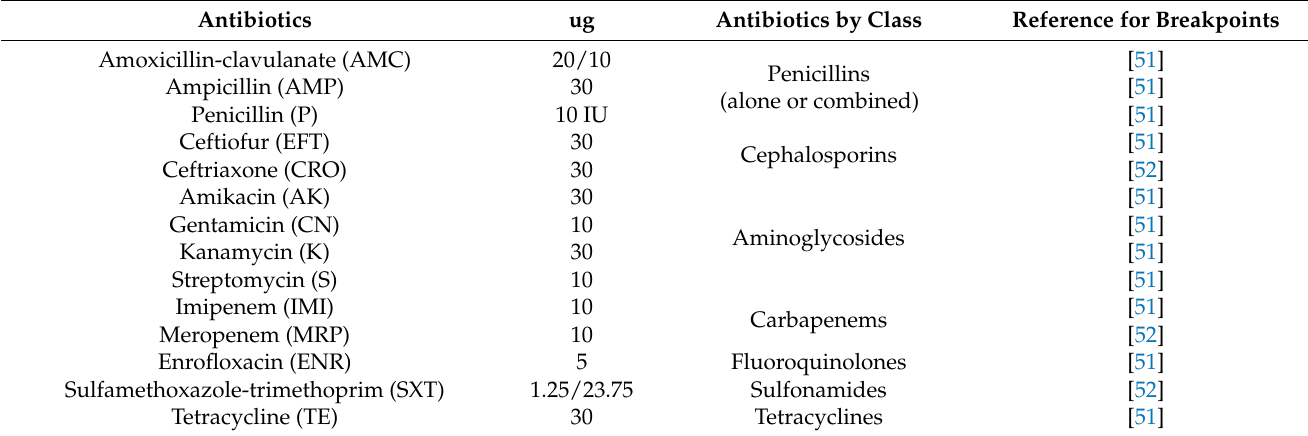
Table 2. Antibiotics and antibiotic classes tested for equine S. zooepidemicus